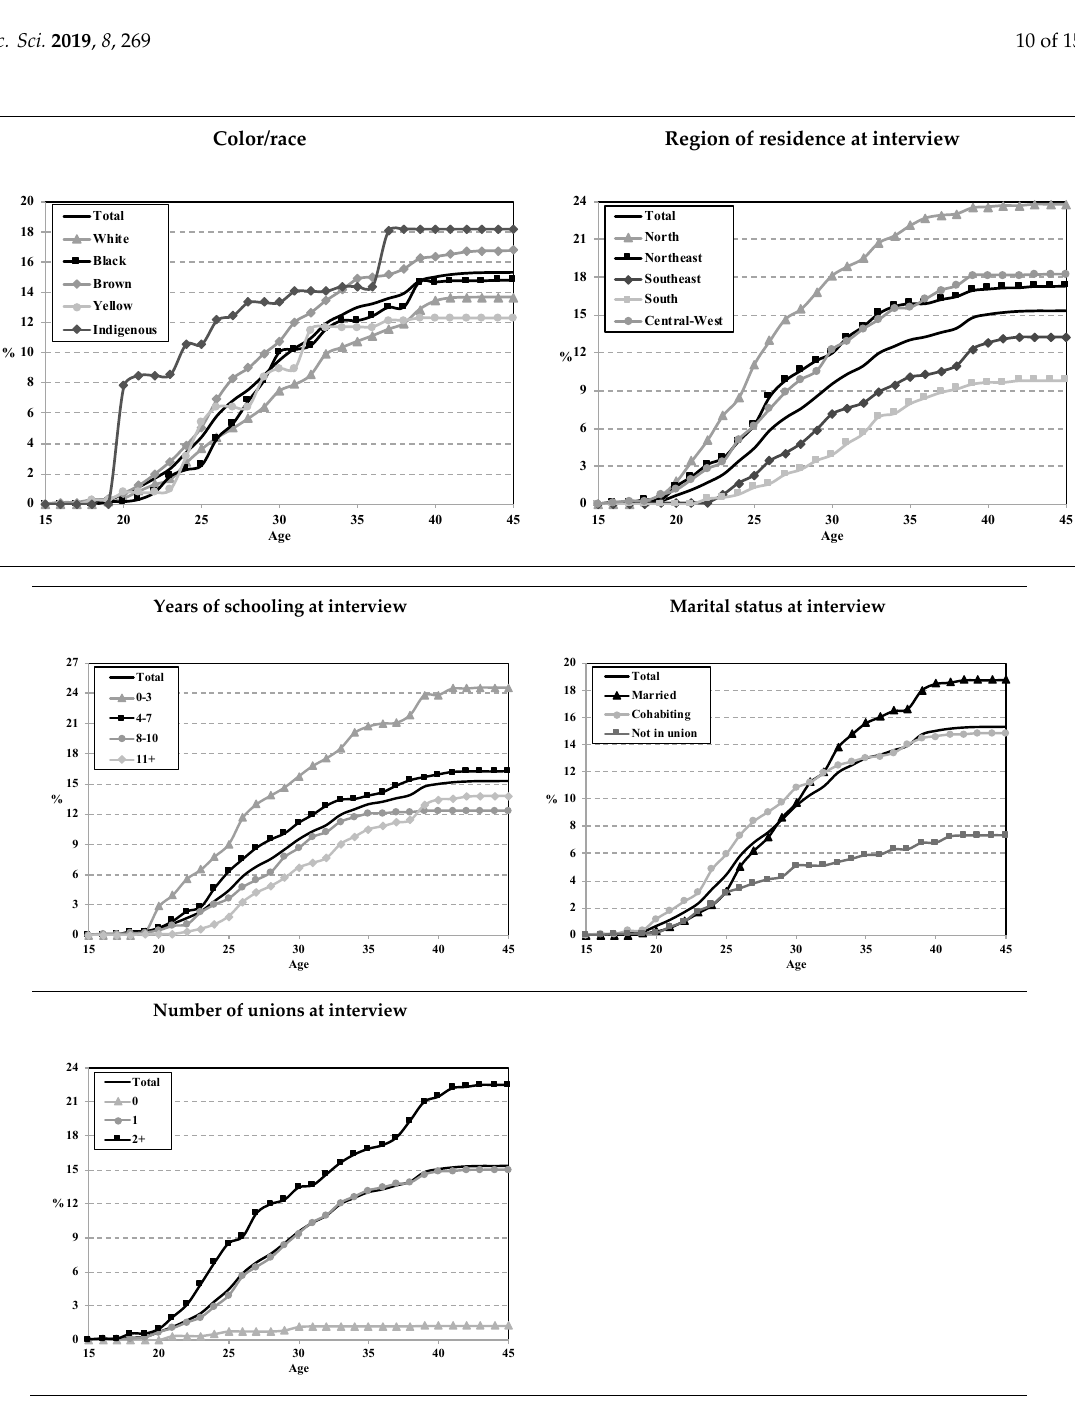
Figure 2. Cumulative percentage distribution of sterilized women by age at the moment of sterilization, Brazil, January 2001 to July 2007. Source: 2006 Brazilian National Survey on Demography and Health of Women and Children (PNDS).